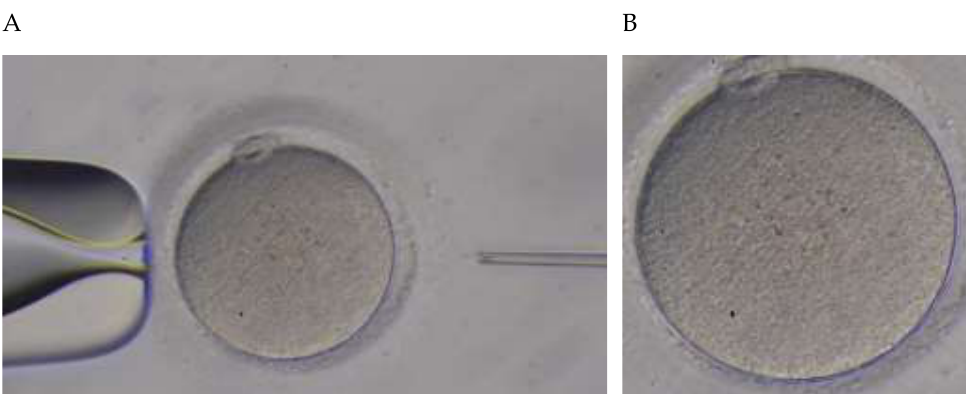
Figure 2. Image of oocyte. ( A ) Raw frame image of 960 pixels width and 540 pixels height, captured from microscopic movie. ( B ) Trimming image of 380 pixels width and 370 pixels height specified, based on the raw frame image A, is an analyzed target image.